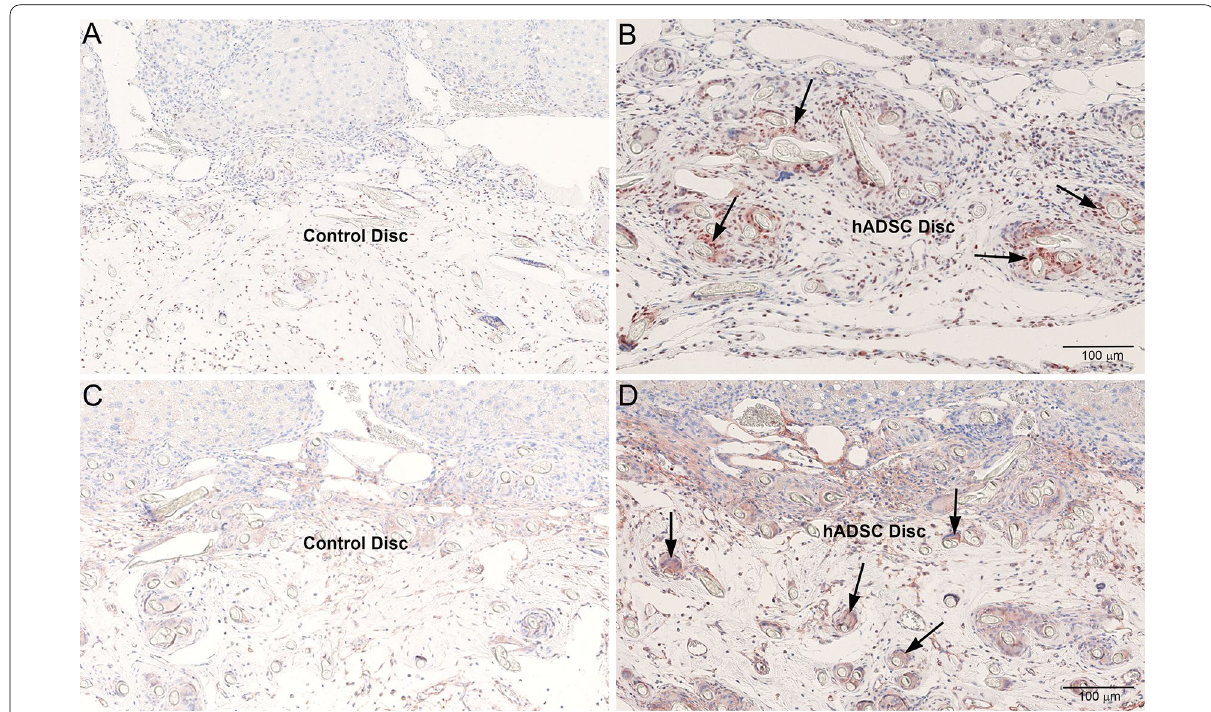
Fig. 9 Immunohistochemical staining for human lamin B1 and CD73 at 8 weeks after implantation of hADSC disc on rat livers. A Implantation of disc alone without hADSCs. Staining for lamin B1 was completely absent. B Positive staining for human lamin B1, a characteristic highly conserved marker to demonstrate that the cells are human origin (arrows). C Implantation of disc alone without hADSCs. Since CD73 is expressed on subsets of T and B lymphocytes, biliary epithelial cells, and sinusoidal endothelial cells, there was focalized moderate staining for CD73 in the hepatic parenchyma. D Adipose-derived stem cells were stained positive for CD73